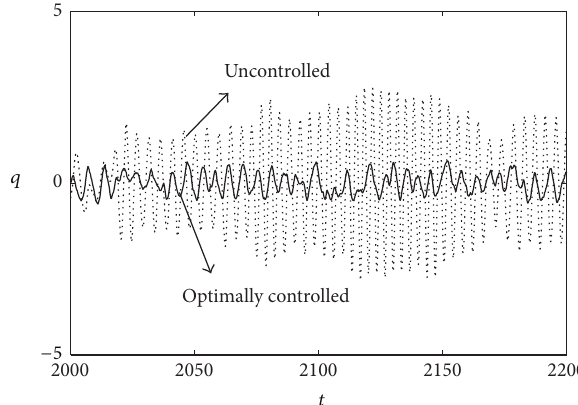
Figure 8: The sample time history of displacements of uncontrolled and optimally controlled system